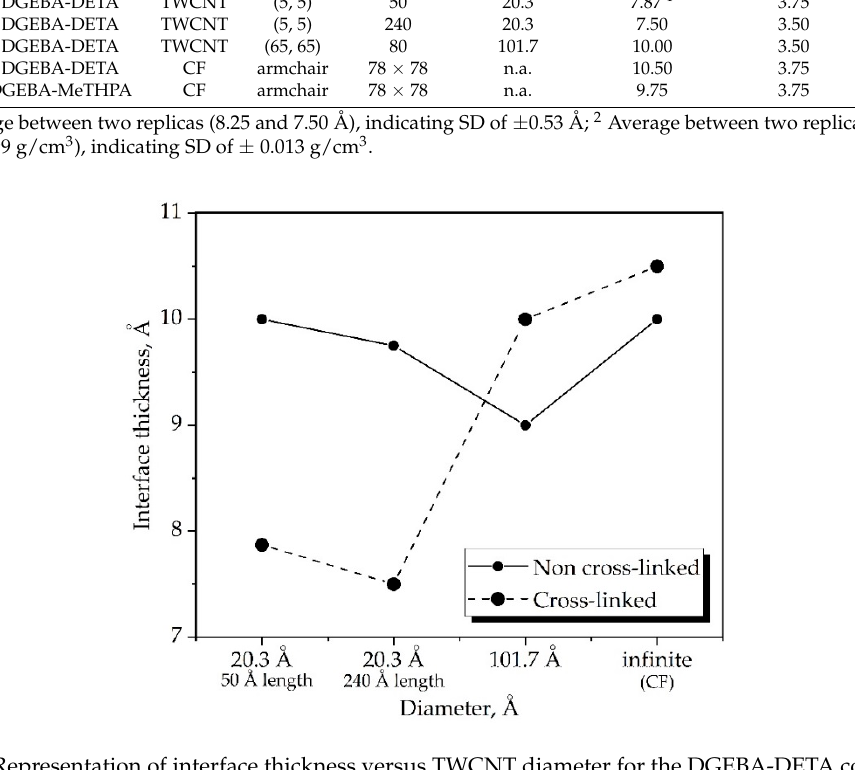
Figure 7. Representation of interface thickness versus TWCNT diameter for the DGEBA-DETA composites.